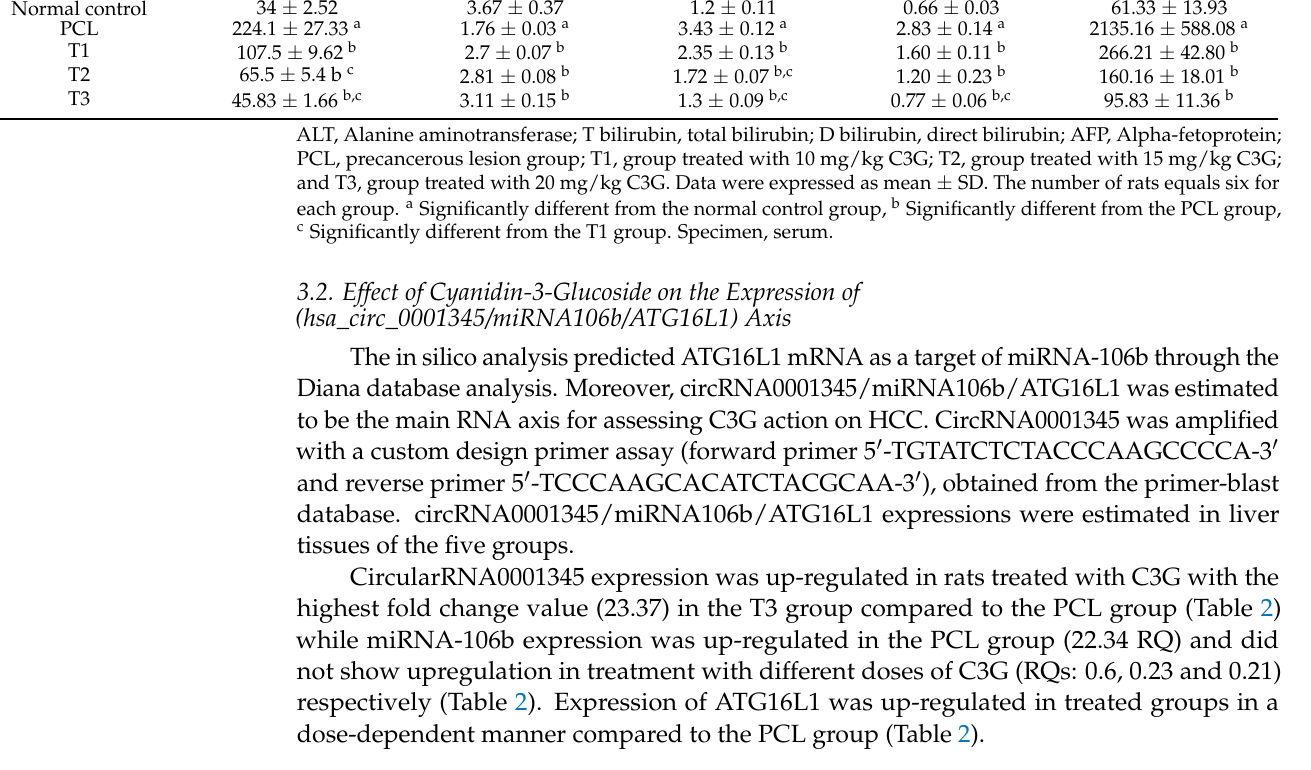
Table 2. Expression levels (relative quantification, RQ) of circRNA 0001345, miRNA 106b, and mRNA ATG16L1 among the investigated groups of